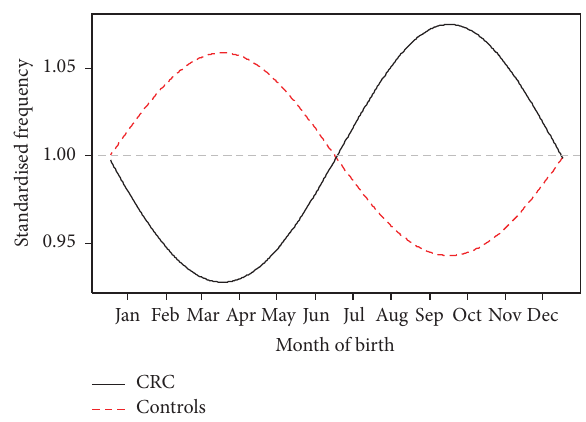
Figure 1: The smoothed graph shows the standardized predicted values by control/CRC status standardized by their means. There seems to be an excess of CRC cases born in early autumn and a corresponding reduction of risk among those born in spring. The seasonal birth patterns among CRC differ from those who did not have CRC ( p = 0.026).